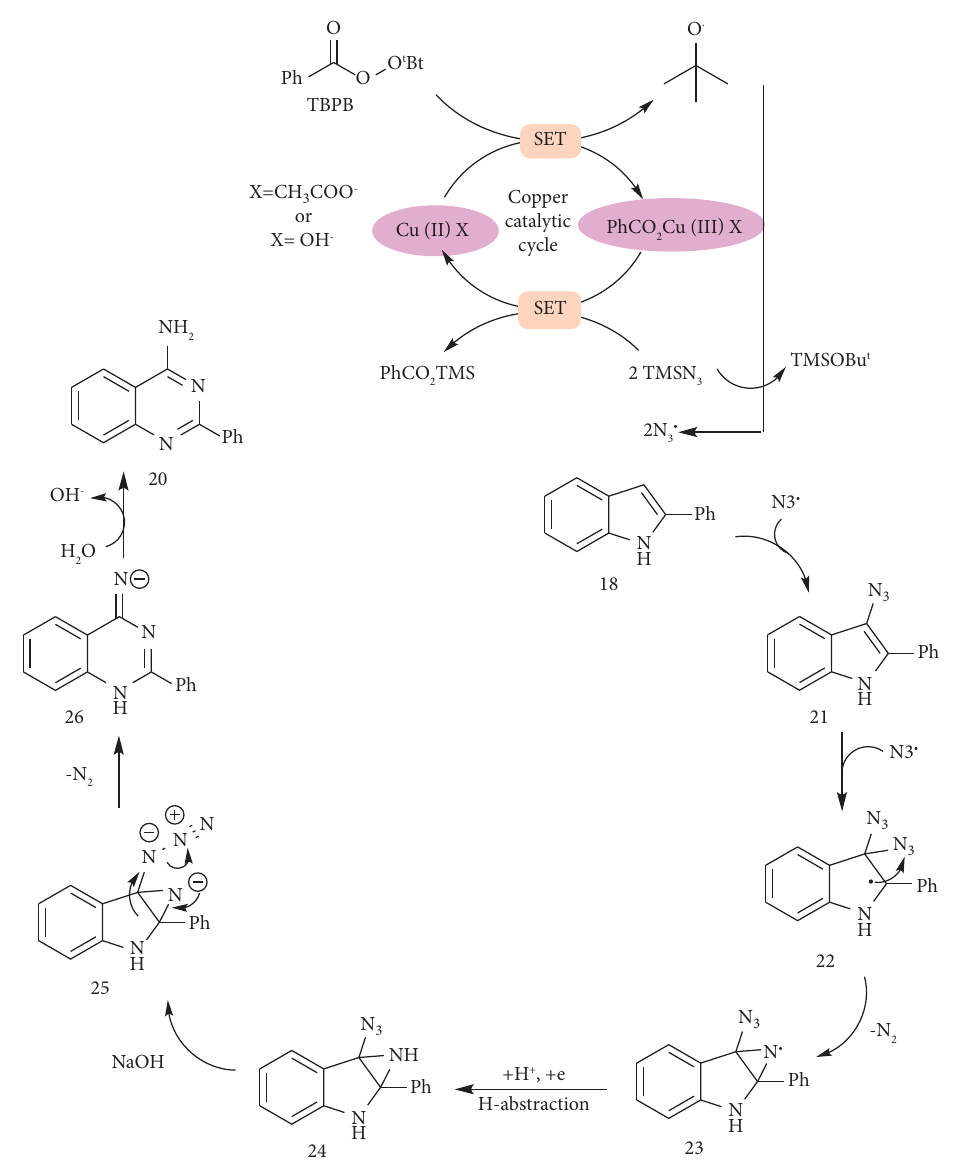
Figure 5: Te plausible mechanism for the synthesis of 2-arylquinazolin-4-amines in the presence of Cu(OAc)